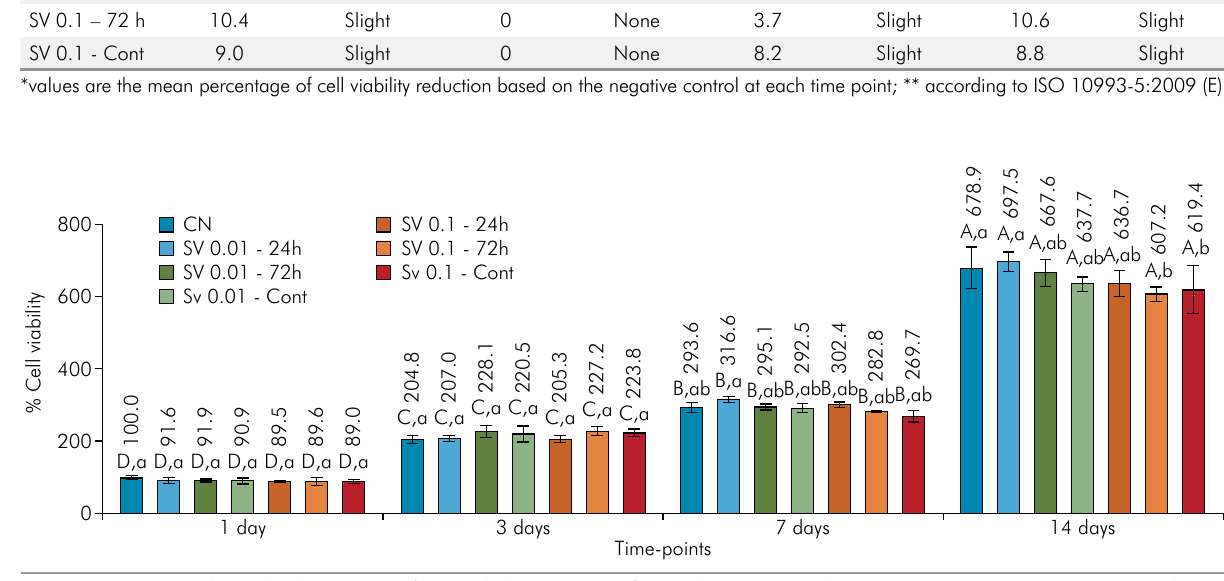
Figure 2. Mean and standard deviation of cell viability values (%) for each experimental group at the time points. Uppercase letters allow comparison among the time points for each experimental group. Lowercase letters allow comparison among the groups within each time point. Different letters show significant differences (n=6; tests: ANOVA and Tukey; p <